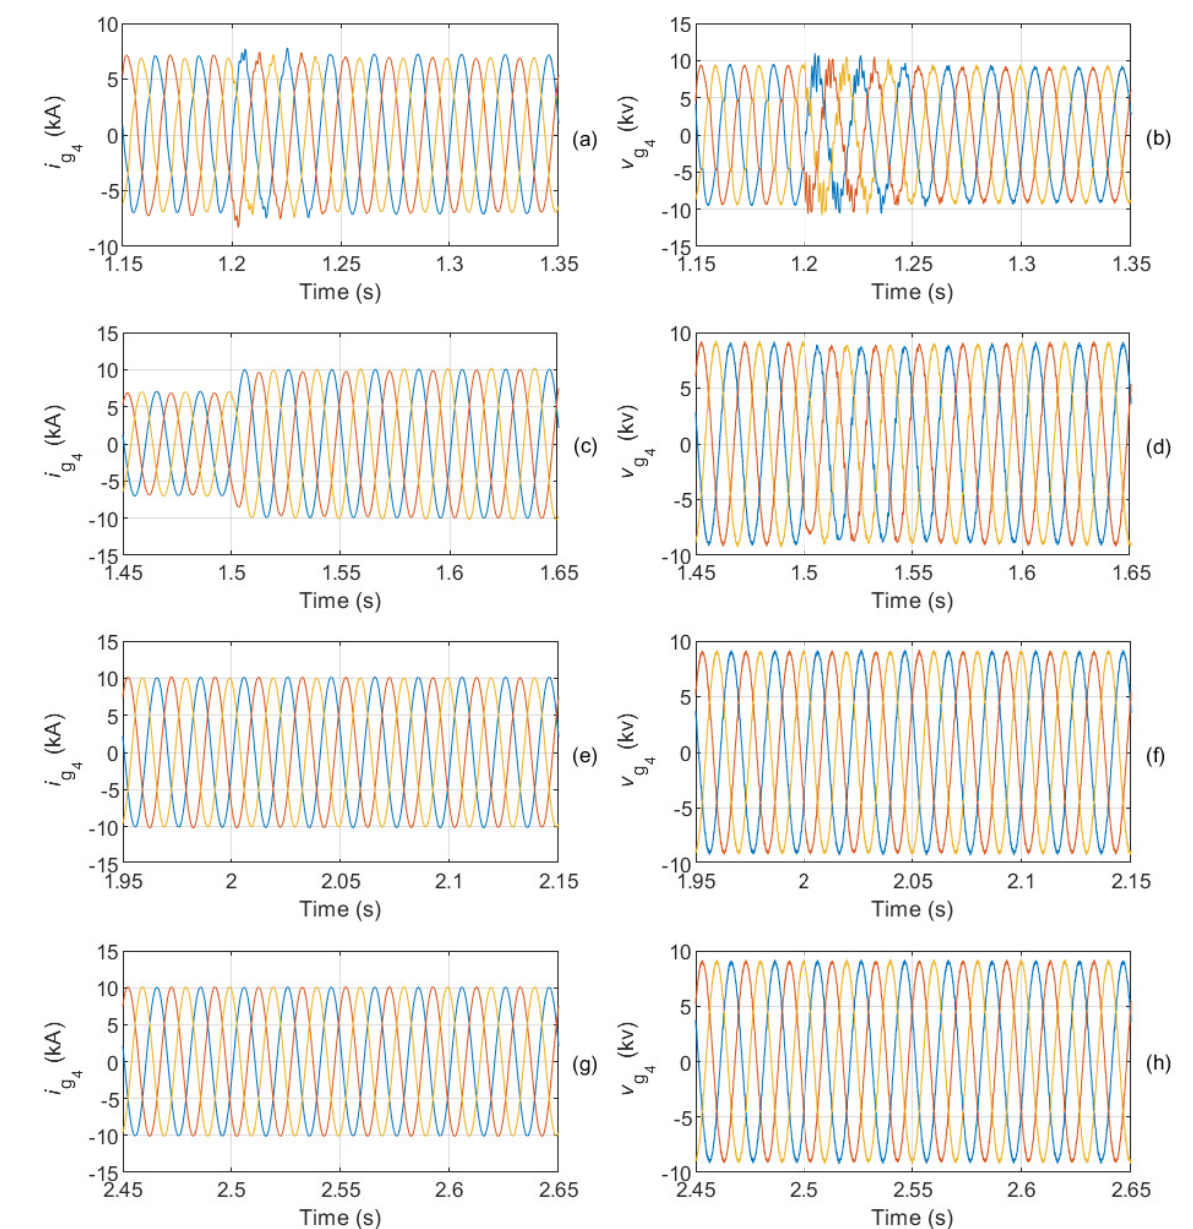
1.35 s), t ≤ ≤ 1.65 s), ( d ) line-to-neutral t ≤ ≤ 2.15 s), ( f ) line-to-neutral voltages at PCC 4 t ≤ ≤ 2.65 t ≤ ≤